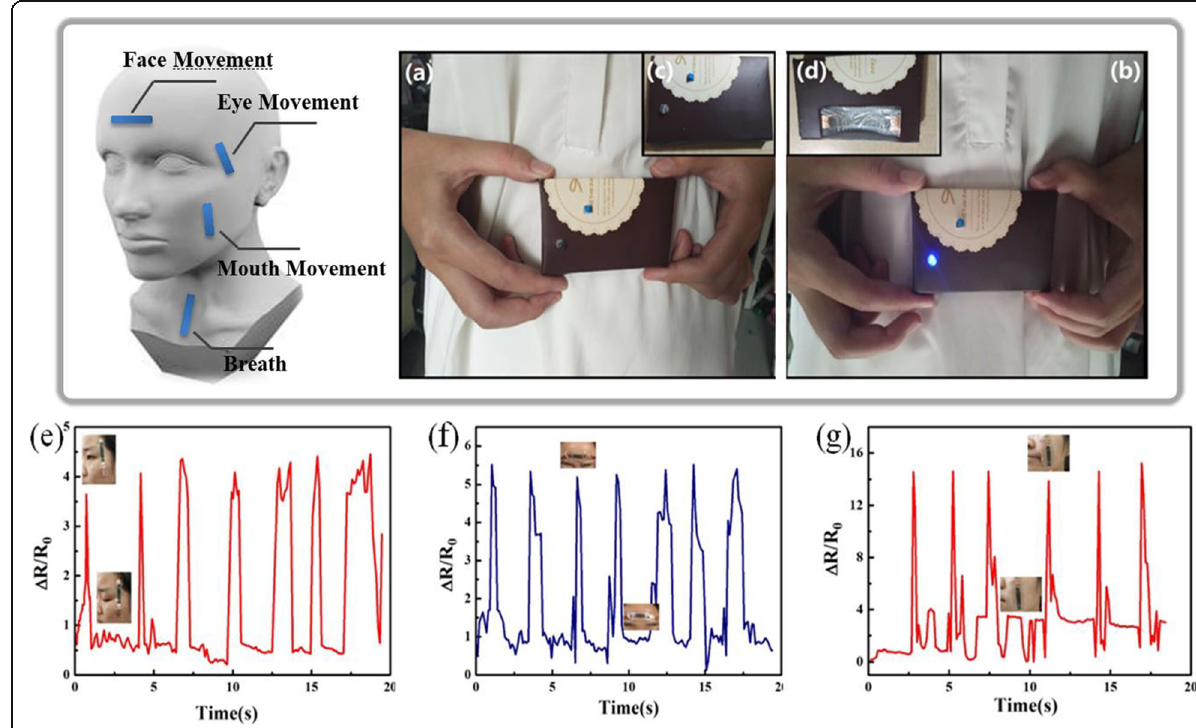
Fig. 5 Portable breathing detector based on Ag@OH-f MWCNT soft strain sensor with wrinkled structure. a Breathing in and ( b ) breathing out. Pictures of the ( c ) top and ( d ) bottom sight from the portable breathing detector. e Facial, ( f ) frown, and ( g ) smile expression recognition of